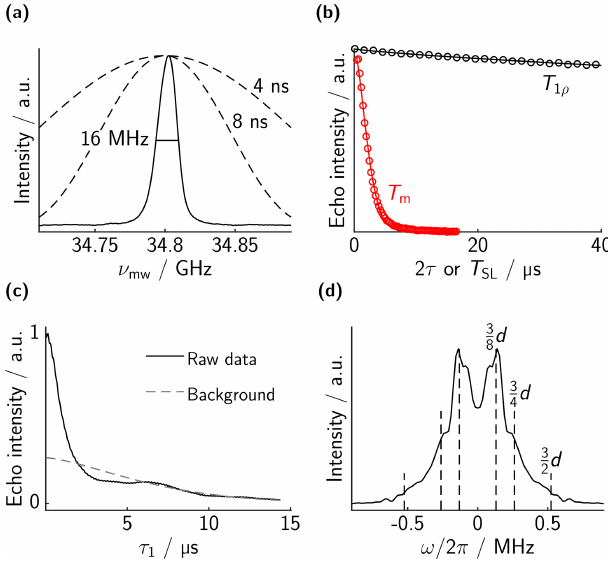
Figure 5. Measurements on bis-trityl 2 . (a) EPR spectrum. (b) Bare-spin decoherence (two-pulse echo decay, red) and dressed- spin polarization decay (spin-locked echo decay, black). Experi- mental points in circles (not all points shown for clarity) and best fit in solid lines. The fitted values are T m = 2 . 6µs ( ξ = 4 . 9) and T 1 ρ ≈ 730µs ( ξ = 2 . 4). (c) PM echo evolution as a function of τ 1 = τ 2 . A stretched exponential background with T 2 ρ = 14 . 5µs ( ξ = 4 . 4) is shown in grey. The dipolar oscillations are damped and the background obscures the oscillations at long dipolar evolution times. (d) Dipolar spectrum obtained by a Fourier transform of (c) after background division. In addition to the singularities expected from our basic theoretical treatment, strong singularities at 3 / 8 d are apparent. These features are explained in the main